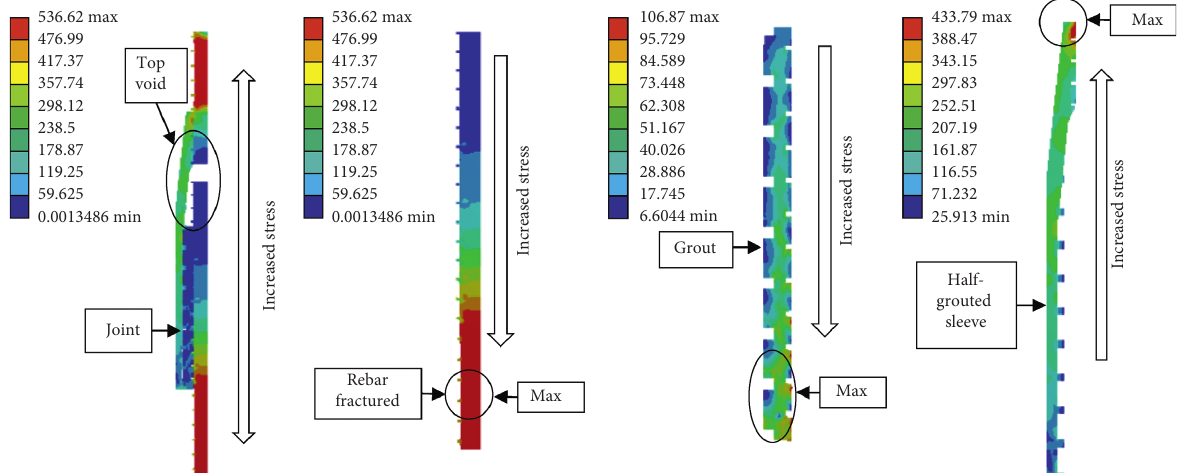
Figure 11: The finite element stimulation stress distribution diagram of the vertical insufficient grout height specimen (88mm: 5.5d; unit: